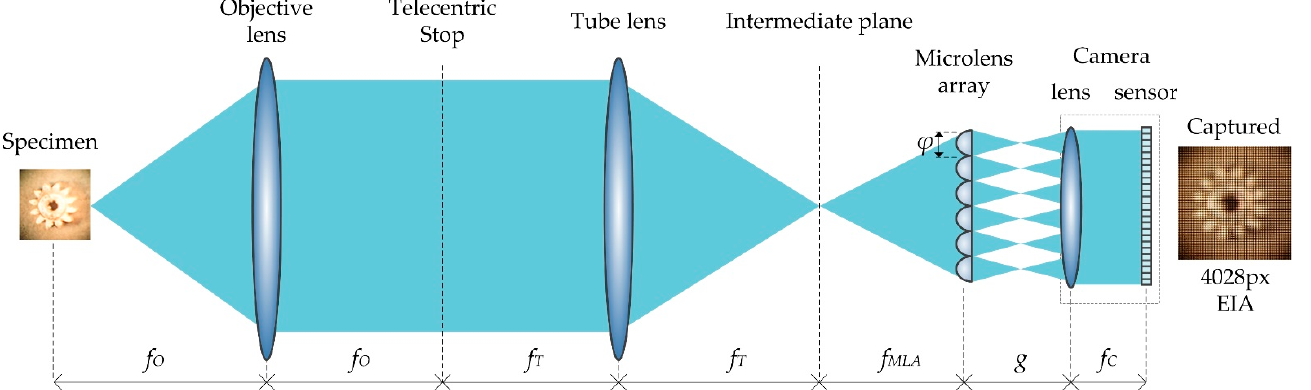
Figure 1. Schematic diagram and image capturing system of an IIM system. Microlens arrays are placed in front of the sensor to capture EIs from an object placed in front of the objective lens and magnified by the tube lens.